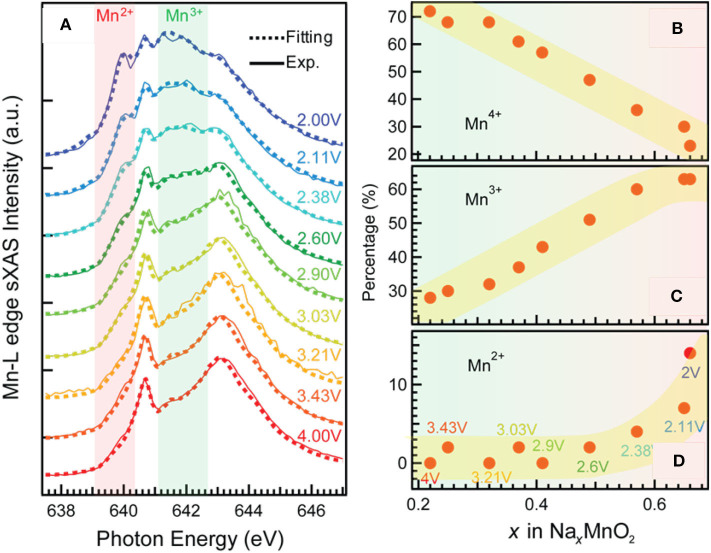
Mn-L soft X-ray absorption spectroscopy–total electron yield (sXAS-TEY) spectra collected on a series NaxMnO2 electrodes at various state of charge (A) and the variation of Mn2+/3+/4+ concentrations (B–D) achieved by linear combination of reference spectra of Mn2+ (MnO), Mn3+ (Mn2O3), and Mn4+ (Li2MnO3). Reprinted from Qiao et al. (2015a) with permission from Elsevier.